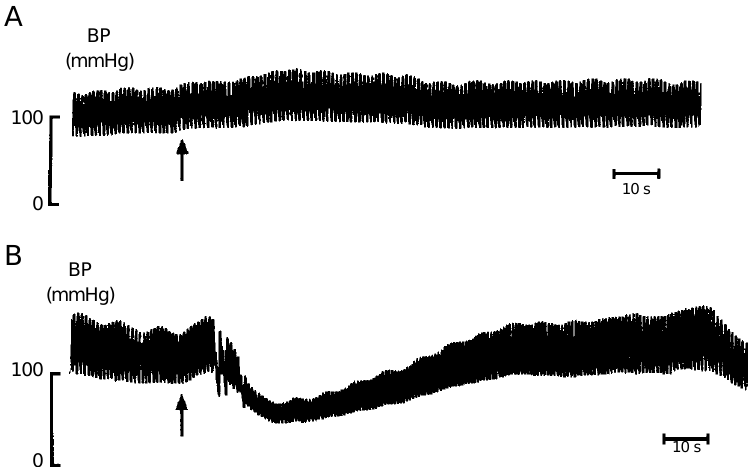
Figure 2 - Changes in arterial blood pressure (BP) in Bradypus variegatus in response to the approach of a human. A , A slight rise and B , a